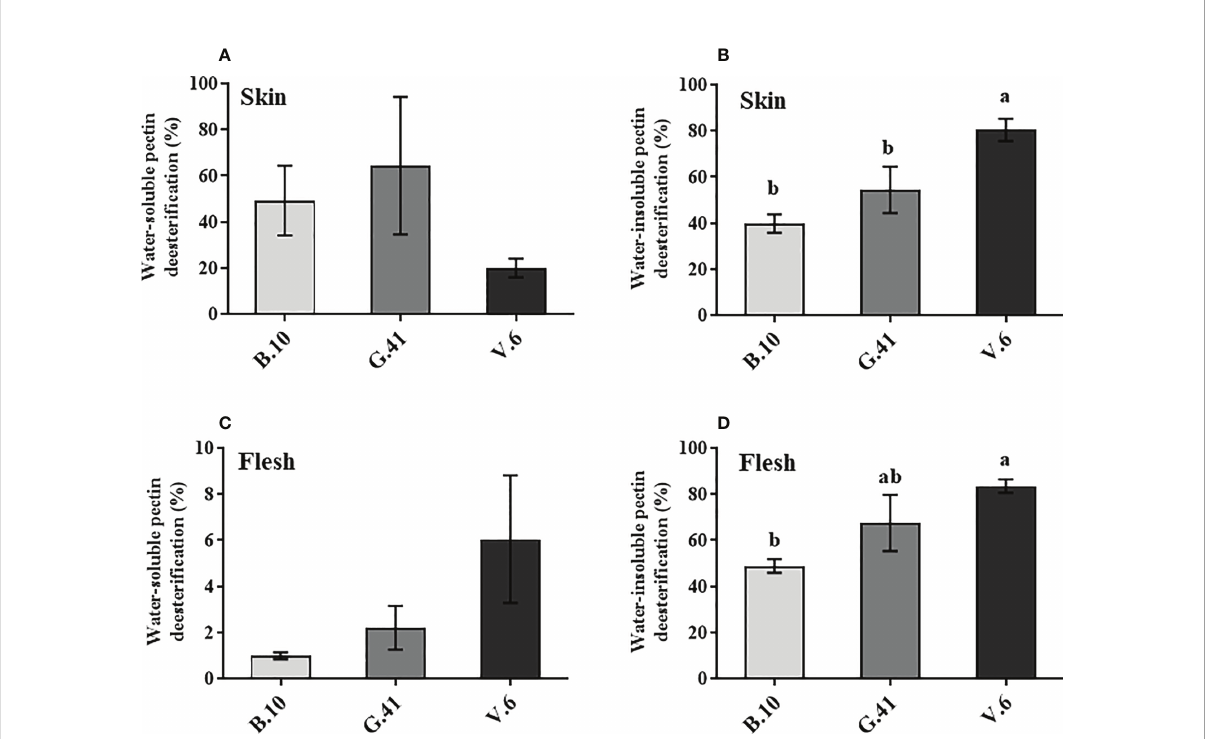
FIGURE 5 Effects of rootstocks on the de-esteri fi cation rate (%) of pectin in ‘ Honeycrisp ’ apples. (A, B) de-esteri fi cation rate (%) of water-soluble and water-insoluble pectin in skin tissues, (C, D) de-esteri fi cation rate (%) of water-soluble and water-insoluble pectin in fl esh tissues of ‘ Honeycrisp ’ apples from B.10, G.41 and V.6 after two months of cold storage. Means not sharing any letter are signi fi cantly different at P < 0.05, according to Tukey ’ s HSD